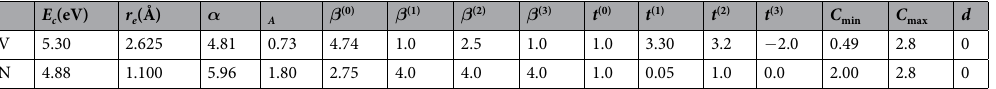
Table 1. Parameters in MEAM potentials for pure V and N. E c , r e , α , A , β , t , C , and d denote cohesive energy, equilibrium nearest-neighbor distance, exponential decay factor, scaling factor for embedding energy, exponential decay factor, weigh factor for atomic densities, screening parameter, and adjustable parameter, respectively.